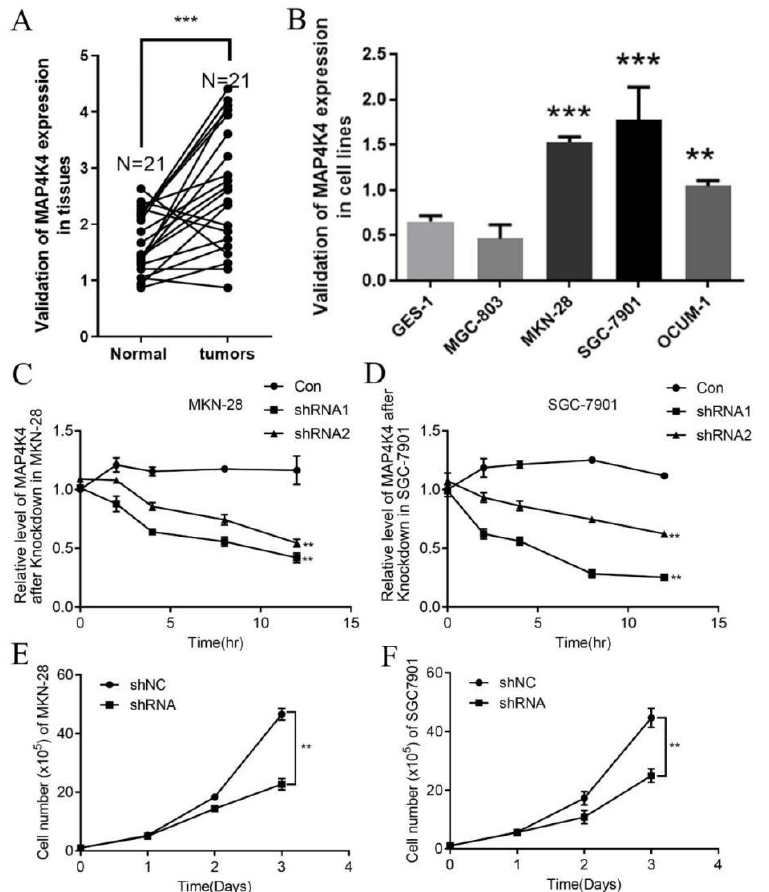
Figure 5. Detection of MAP4K4 expression changes. ( A ) q-PCR detection of MAP4K4 expression in gastric cancer ( n = 21) and adjacent samples ( n = 21), and the significance is conducted by Student’s paired t-test; ( B ) q-PCR detection of MAP4K4 expression of gastric cancer cell lines (MGC-803, MKN-28, SGC-7901, and OCUM-1) and control cells (human gastric mucosa epithelial cell line GES-1); ( C ) relative expression level of MAP4K4 after 0 h, 2 h, 4 h, 8 h, and 12 h of MAP4K4 silencing in MKN-28 cells; ( D ) relative expression level of MAP4K4 after 0 h, 2 h, 4 h, 8 h, and 12 h of MAP4K4 silencing in SGC-7901 cells; ( E ) cell number of MKN-28; ( F ) cell number of SGC-7901 that represent the significant correlation between cell numbers and time interval. A total of 375 gastric cancer and 294 normal samples are checked for statistical variation and calculated using Fisher’s exact test. Data are derived from independently repeated experiments (Mean ± SD). ** p < 0.01, *** p < 0.001.